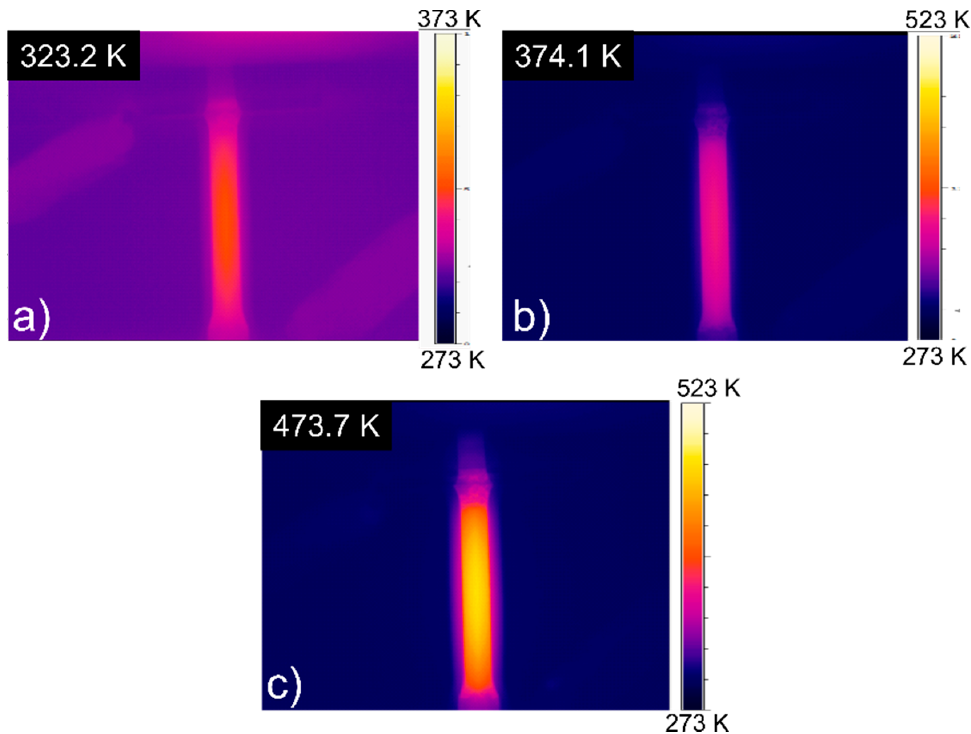
Figure 4. Representative picture of thermal imaging with recorded maximum values prior tension for ( a ) 323 K, ( b ) 373 K, and ( c ) 473 K.